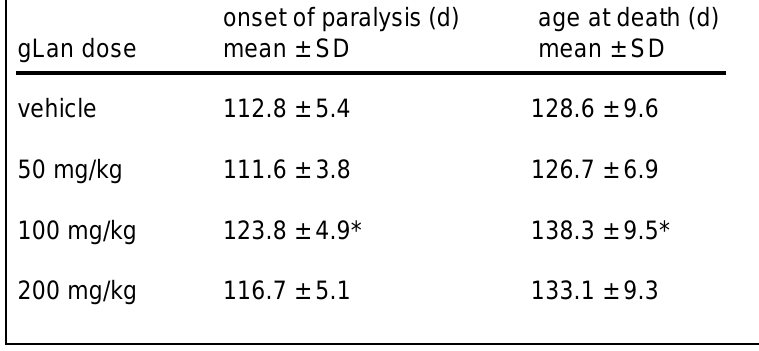
Table 2. Effects of gLan upon onset-of-paralysis and age-at-death parameters in SOD1 G93A mice treated with the indicated daily dose of gLan beginning at 90 d as indicated in text and Figure 4. * p < 0.02 by two-tailed